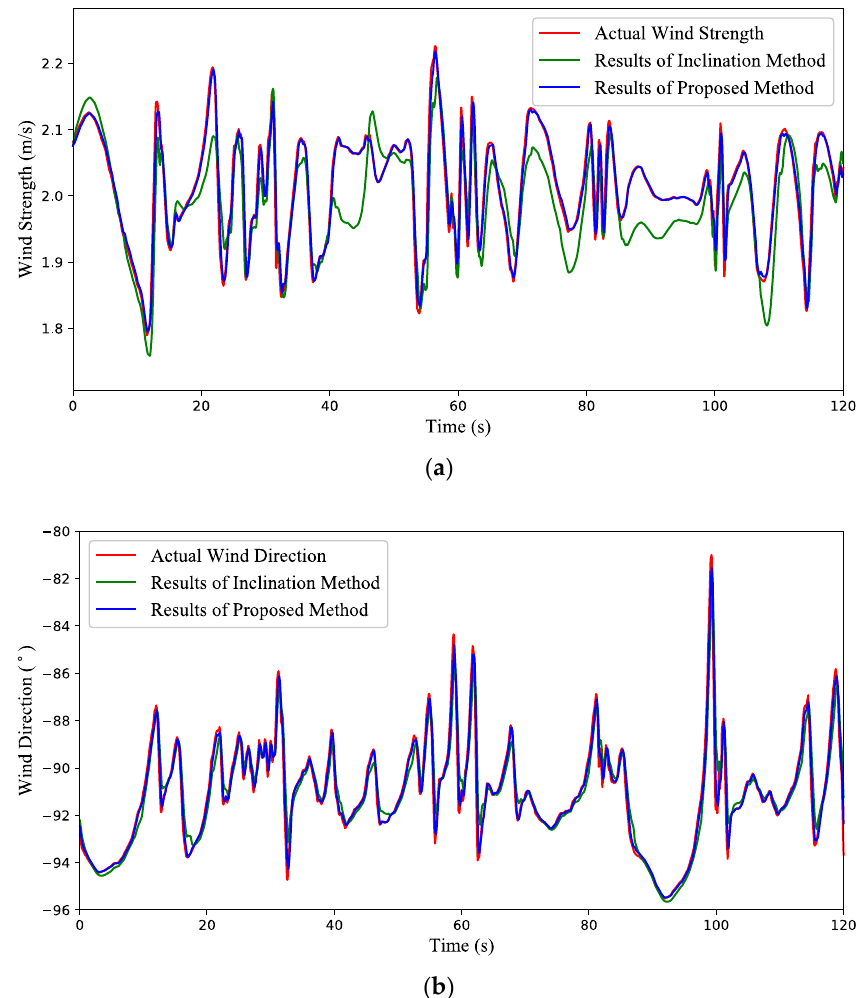
Figure 10. Simulation results of the time-varying wind estimation with a quadrotor in hovering condition. ( a ) The wind strength. ( b ) The wind direction.